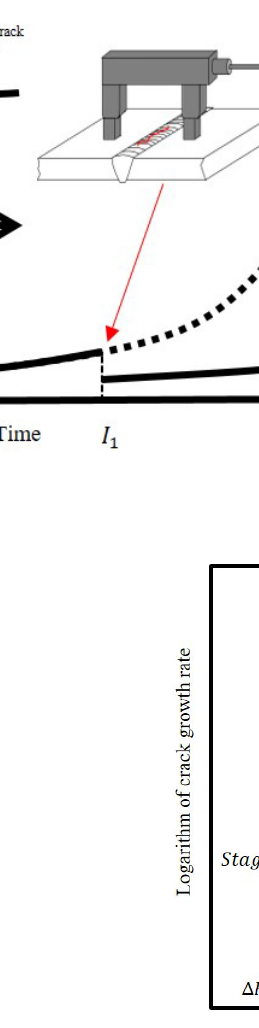
Figure 3. Schematic of crack propagation curve according to the Paris–Erdogan law (Amirafshari, 2019). Figure 4. Schematic of crack growth models by the Paris